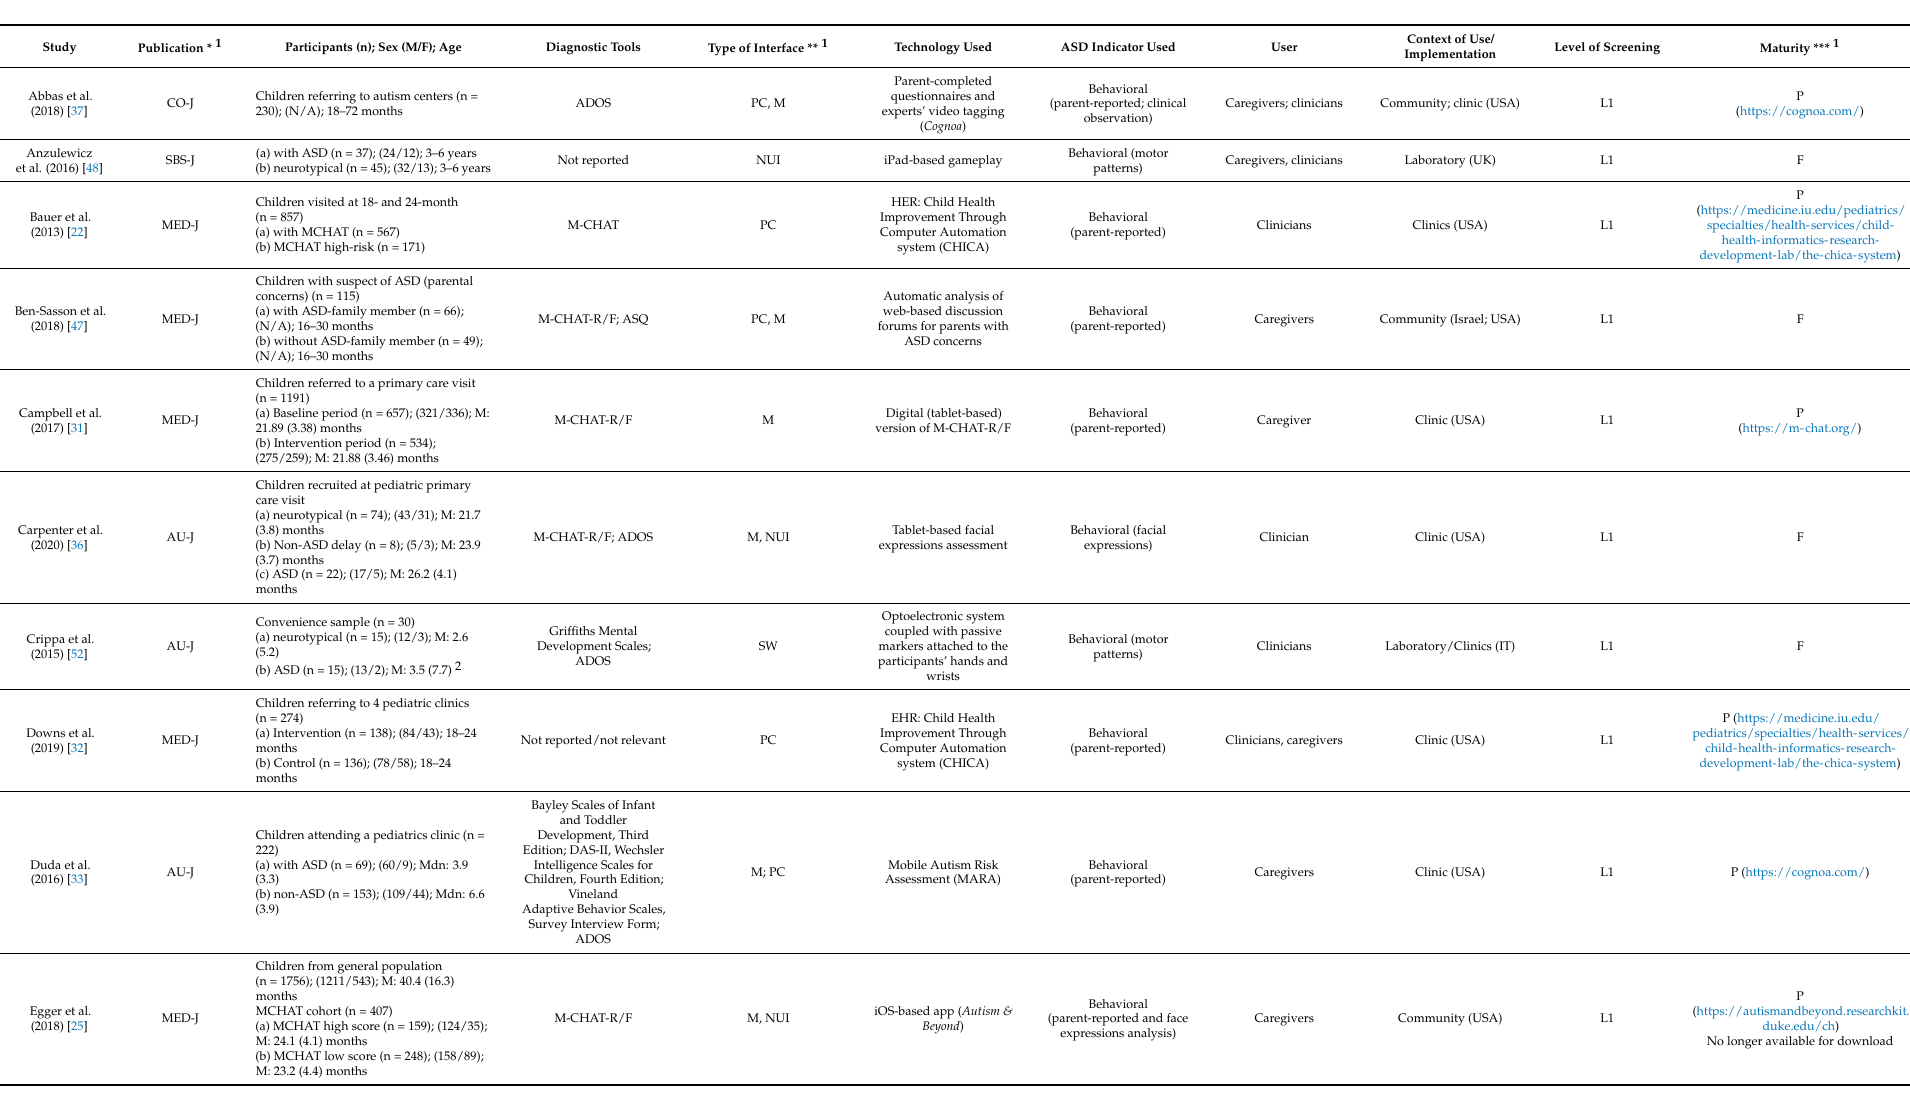
Table 1. Studies included in the